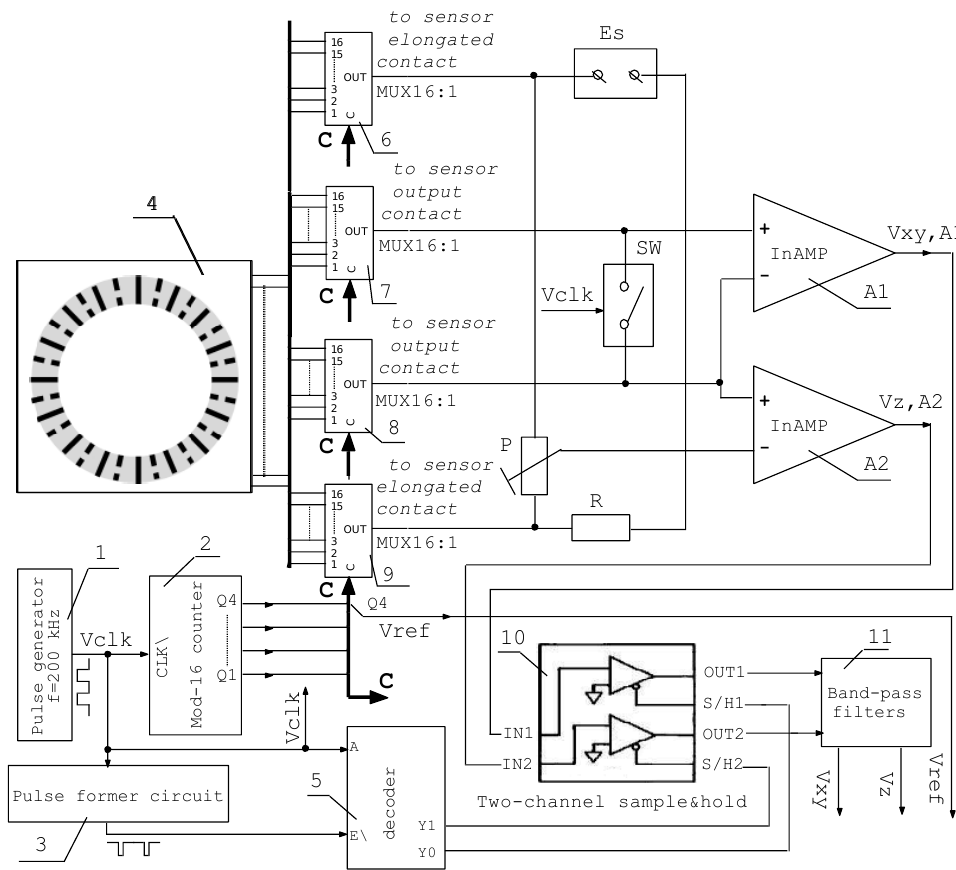
Figure 3. Block diagram of the